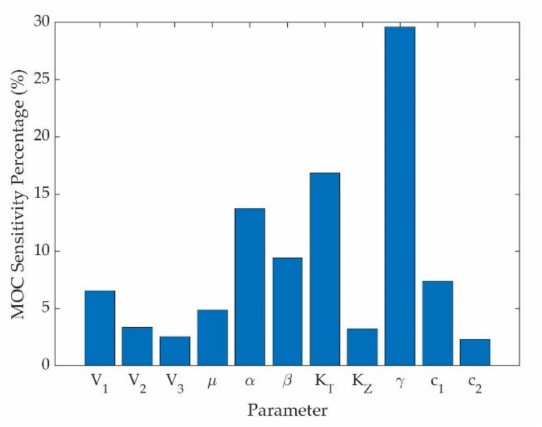
Figure 8. Sensitivity percentage of the MOC in parameter space. The spread of q is obtained by the time average of the last 200